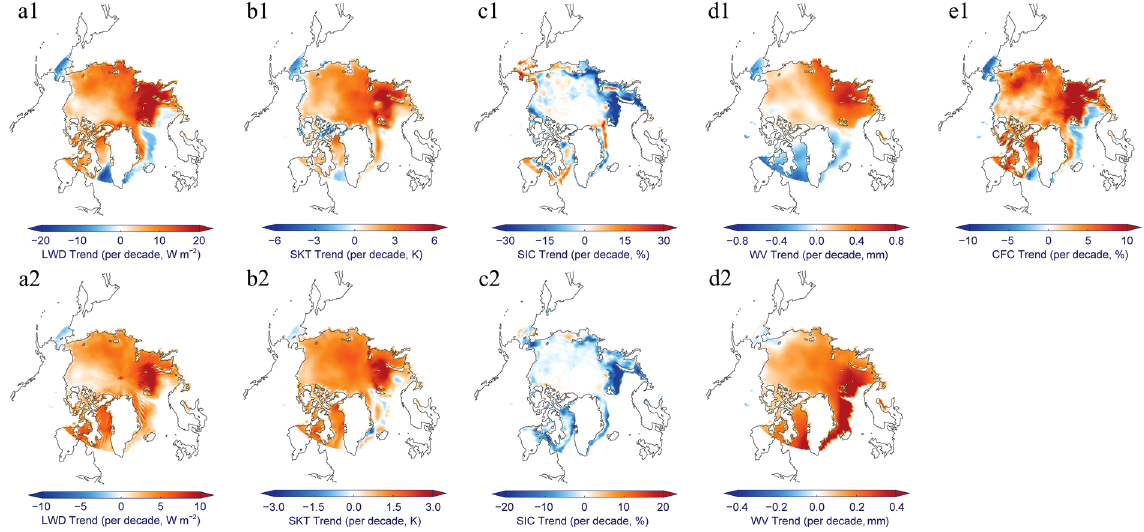
Figure 2. Observed trends for all five variables. Linear trends in ( a1,a2 ) surface LWD, ( b1, b2 ) SKT, ( c1,c2 ) onset SIC, ( d1,d2 ) WV, and ( e1 ) CFC from 2001 to 2014 (upper panels) and from 1985 to 2014 (lower panels). This figure has been created with IDL8.3 (Exelis Visual Information Solutions, Boulder, Colorado) and the open source Coyote Library developed by David Fanning